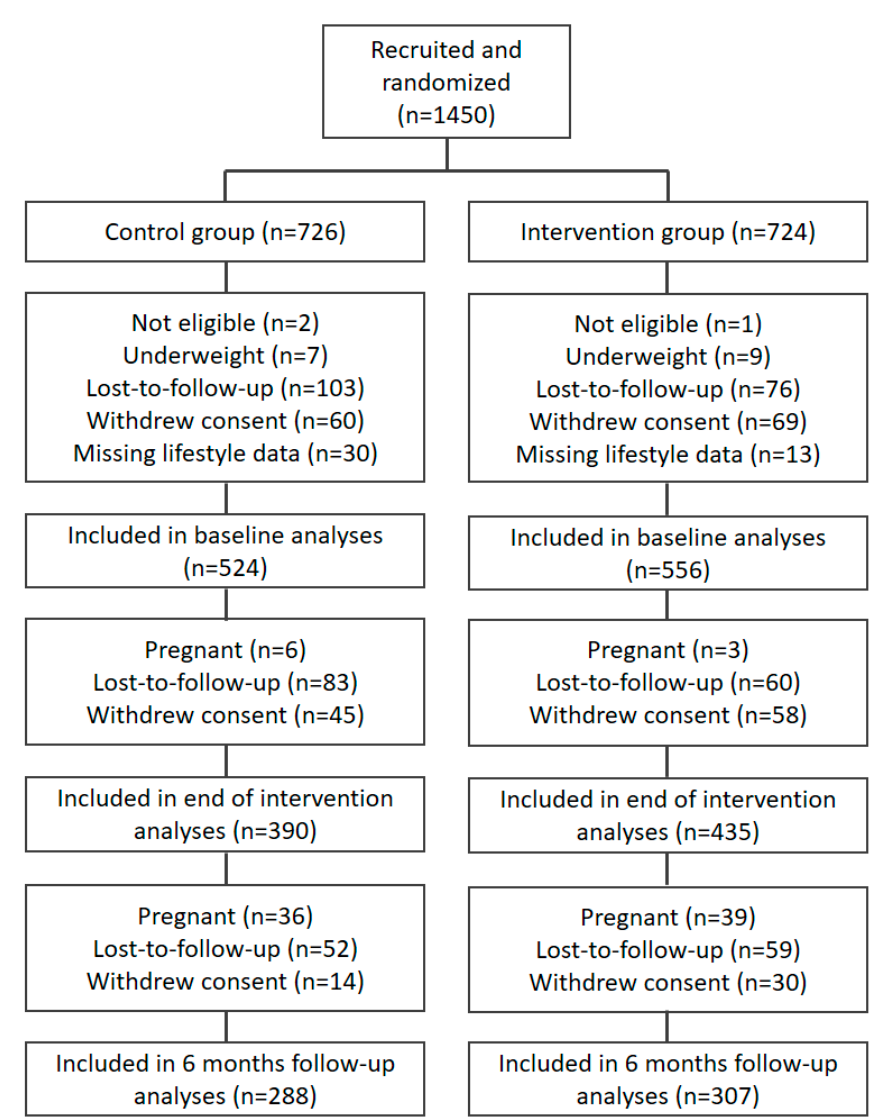
Figure 1. Flow chart of participant follow-up. Table 1. Characteristics of the INTER-ACT participants.